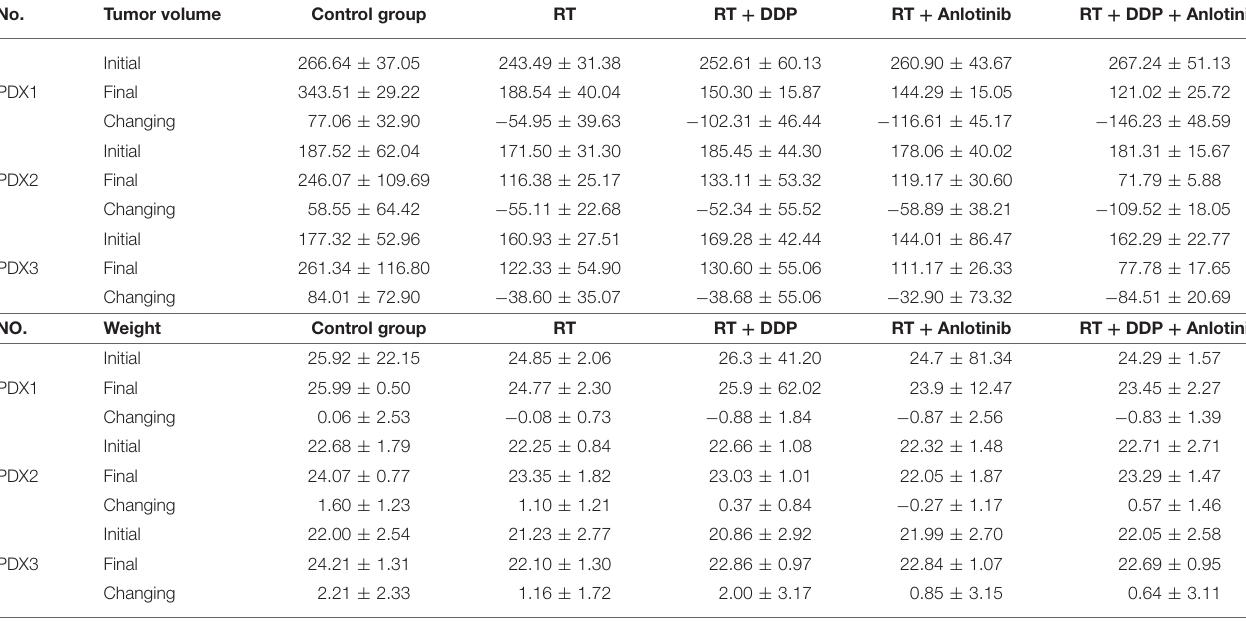
TABLE 2 | The detailed data of tumor volume and body weight.